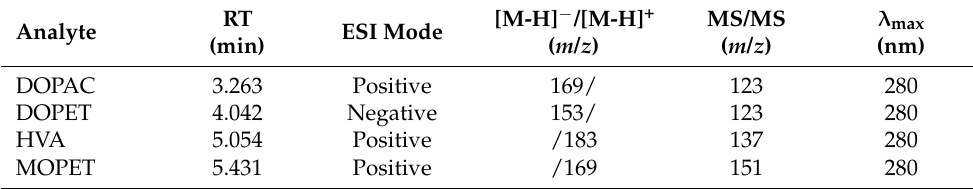
Table 2. LC-DAD-ESI-MS/MS parameters for the quali-quantitative determination of